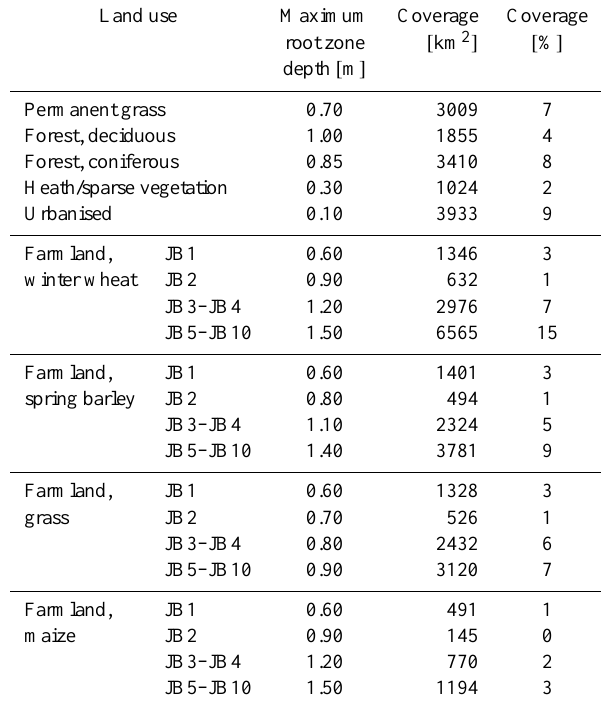
Table 1. Combination of vegetation and soil types defined in the